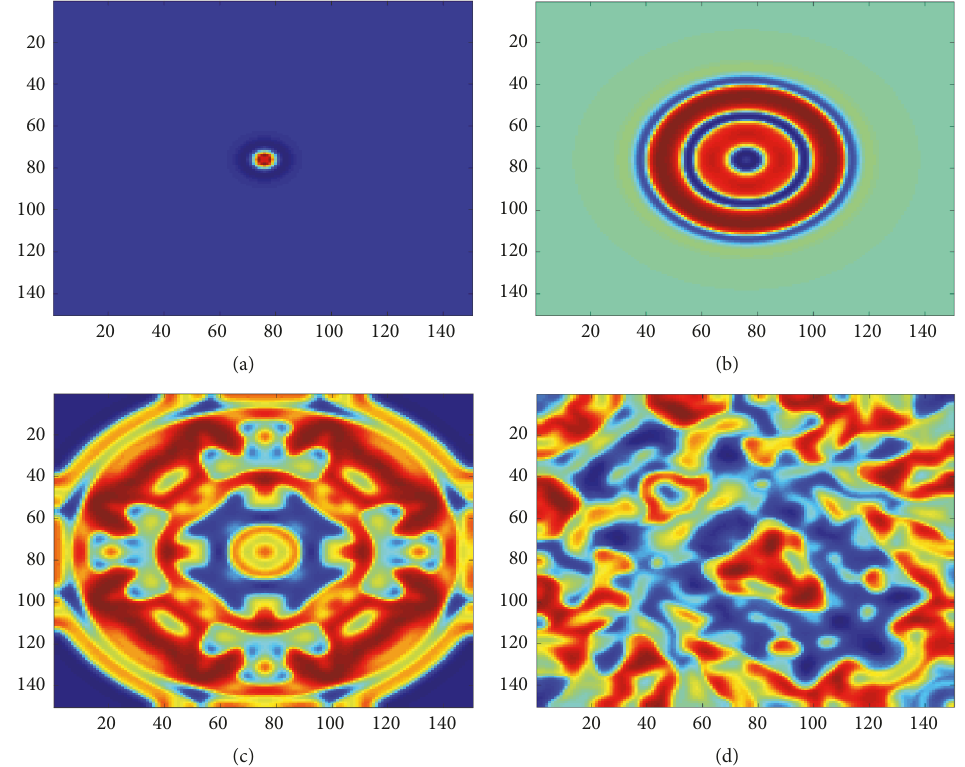
Figure 6: The snapshots of spatial distribution of membrane potential with color scale for neurons in the square array network for 𝑘 = 0.7 and 𝐷 = 5 at (a) 𝑡 = 2 time units, (b) 𝑡 = 75 time units, (c) 𝑡 = 135 time units, and (d) 𝑡 = 300 time units.